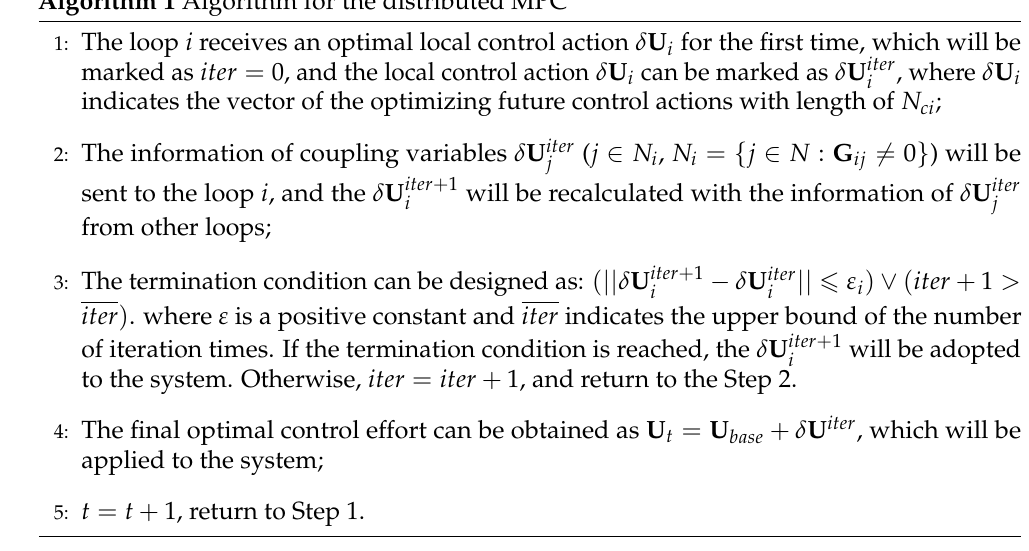
Algorithm 1 Algorithm for the distributed MPC